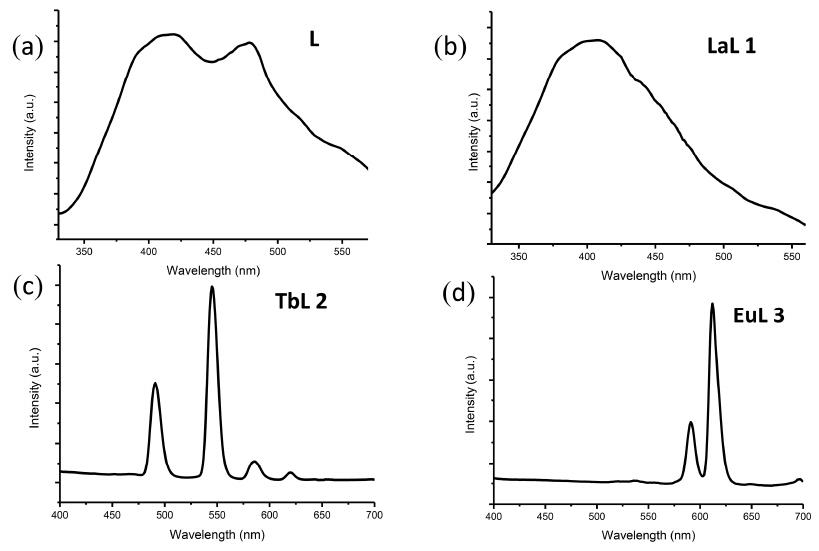
Figure 3. The solid-state emisssion spectra of ( a ) the H 2 LCl ligand with λ ex = 302 nm, ( b ) LaL 1 , with λ ex = 332 nm, ( c ) TbL 2 with λ ex = 332 nm, ( d ) EuL 3 with λ ex = 332 nm.